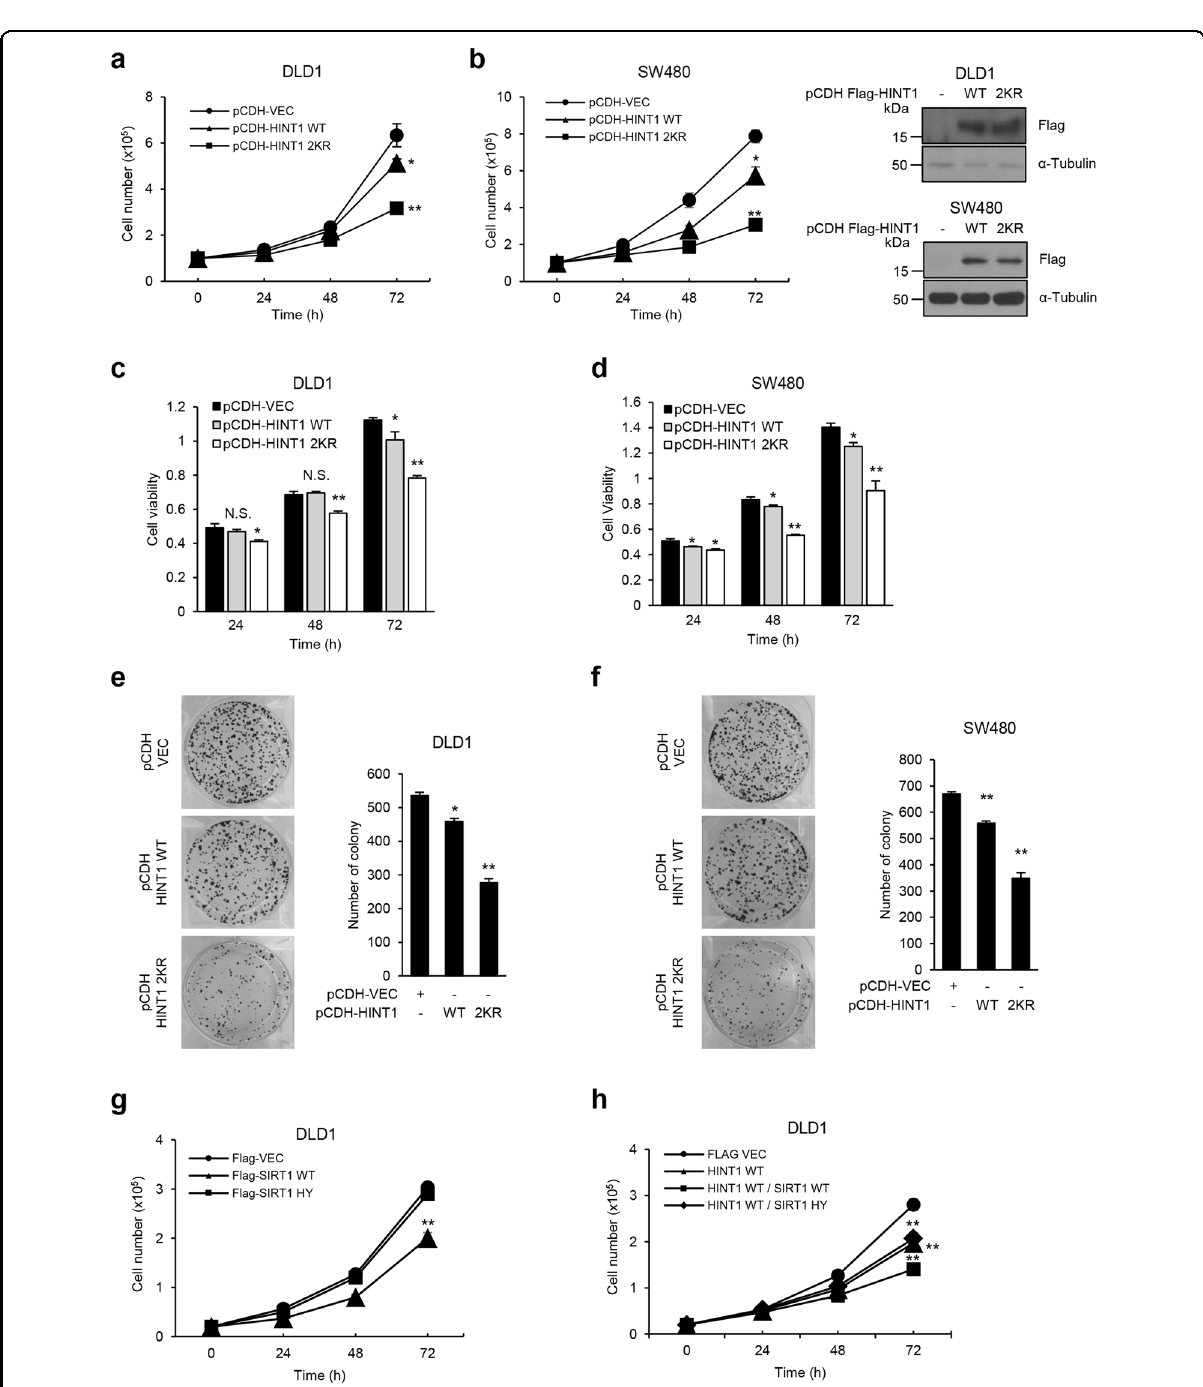
Fig. 5 SIRT1-mediated deacetylation of HINT1 promotes its tumor-suppressive function in colon cancer cell lines. DLD1 and SW480 cells were infected with control or Flag-HINT1 WT or 2KR-expressing lentivirus for 24 h. Lentiviral-infected DLD1 ( a , c ) and SW480 cells ( b , d ) were grown in a 96-well culture plate, and then cell counting was performed ( a , b ) and MTS assay ( c , d ) at the indicated times to determine cell proliferation rates. The same lentiviral-infected cell lines were grown for 14 days. The colonies formed by DLD1 ( e ) and SW480 cells ( f ) were stained and counted. Representative images are shown. Each Flag-SIRT1 WT or HY-expressing construct was transfected alone ( g ) or cotransfected ( h ) with the HINT1 WT construct into DLD1 cells, and then cell counting was performed to determine cell proliferation rates. All data are the mean ± SEM of three independent experiments. * P < 0.05, ** P <